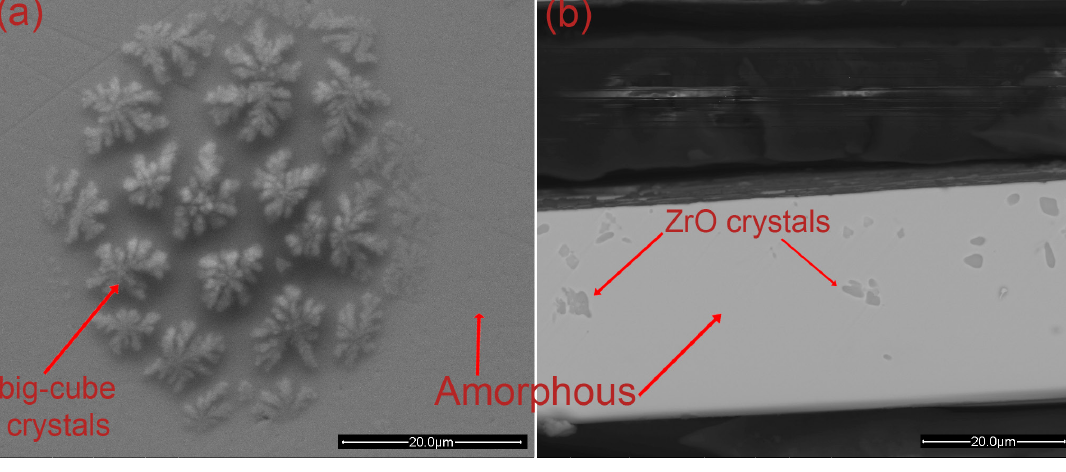
Figure 2. SEM images showing an amorphous matrix and some crystalline phases embedded in the ribbon (a) surface and (b) Table 1. Average compositions (at.%) of the amorphous matrix and the two different crystalline phases as measured by SEM-EDS. The O concentrations are only qualitative and for comparison given the low accuracy associated with quantification using EDS. Region Zr Ni Cu O Amorphous matrix 25.0 46.0 29.0 - Big-cube dendritic crystals (surface) 18.3 25.0 15.3 41.4 ZrO faceted crystals (cross-section) 45.5